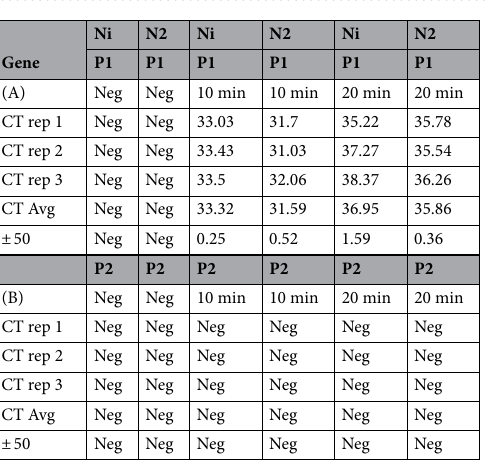
Figure 3. PCR efficiency of SARS-CoV-2 RNA in vLAB at 65 °C and 95 °C. PCR efficiency (E) for N1 and N2 gene was assessed using a duplicate tenfold dilution series of SARS-CoV-2 viral RNA.